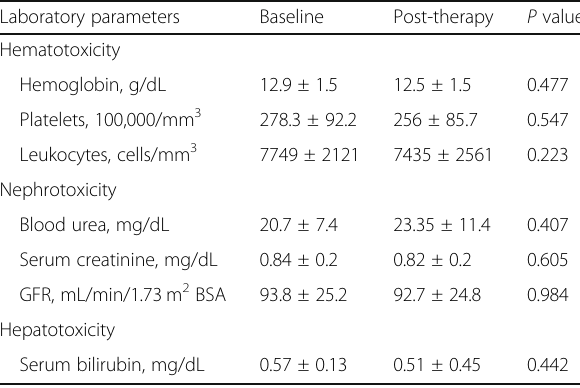
Table 6 Comparison of pre- and post-therapy laboratory parameters Laboratory